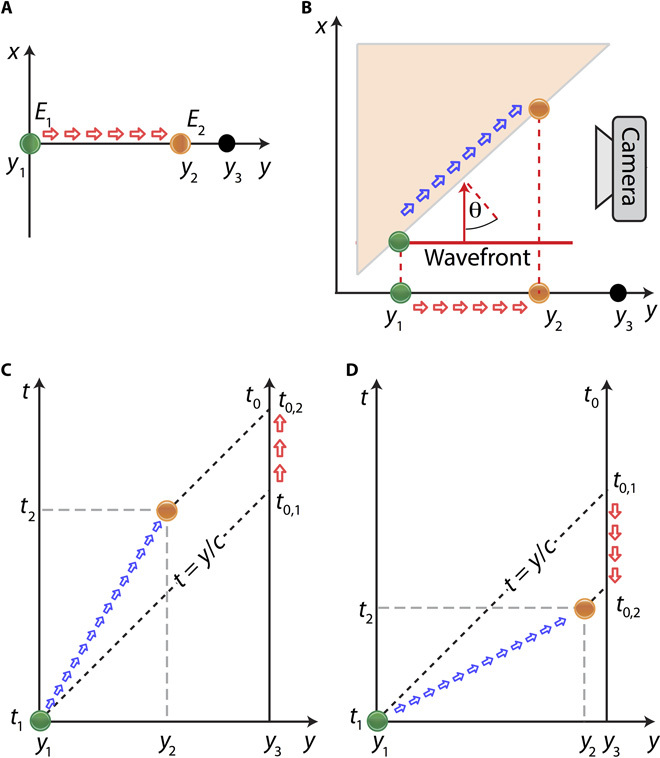
Space-time diagrams.(A) An illustration of the (1 + 1)D example described in the text. (B) The extension of (A) to a (2 + 1)D case that exemplifies the experimental layout. The motion of the scattering source toward the observer (red arrows) can be either superluminal or subluminal. (C) Minkowski diagram for two sequential events. Because this case has v < c, time ordering is preserved. (D) Minkowski diagram for two (causally disconnected) events where v > c: time ordering is inverted.